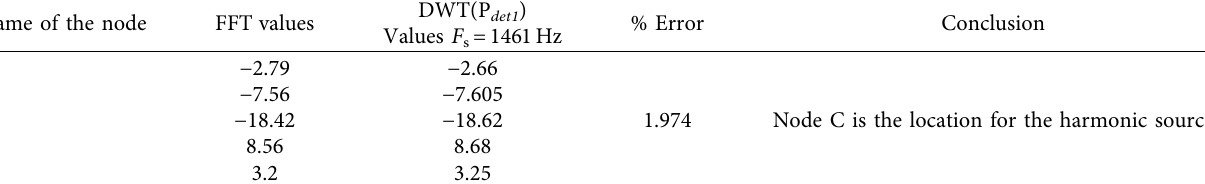
Table 4: 5th harmonic current component contributed by the nonlinear load.